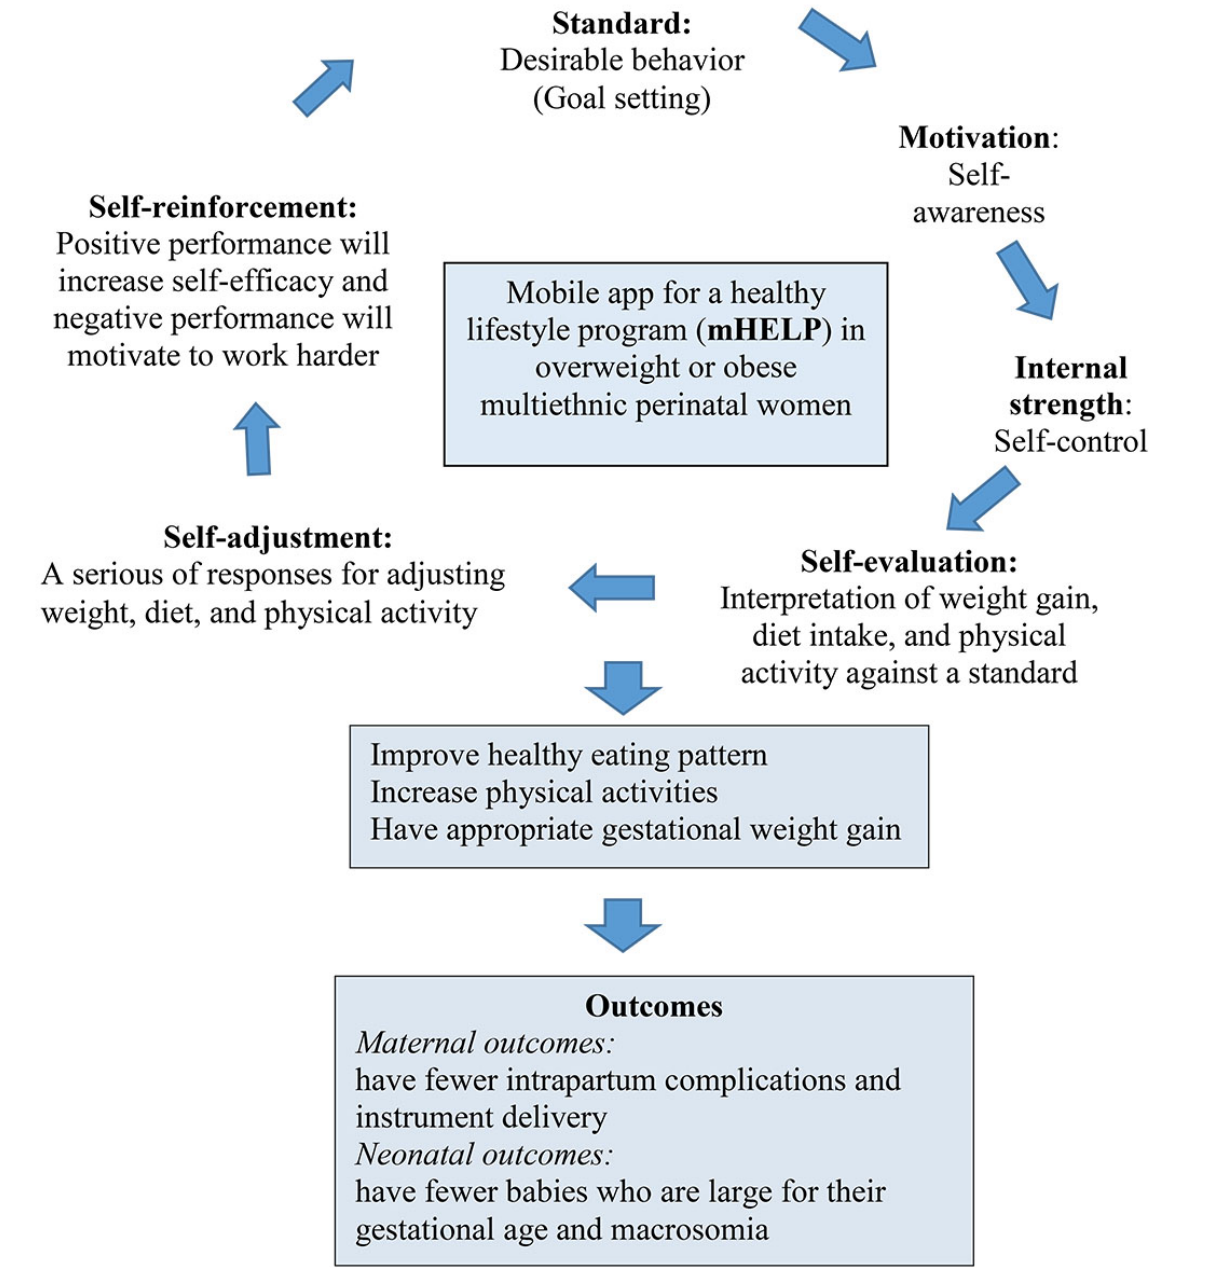
Figure 1. Conceptual